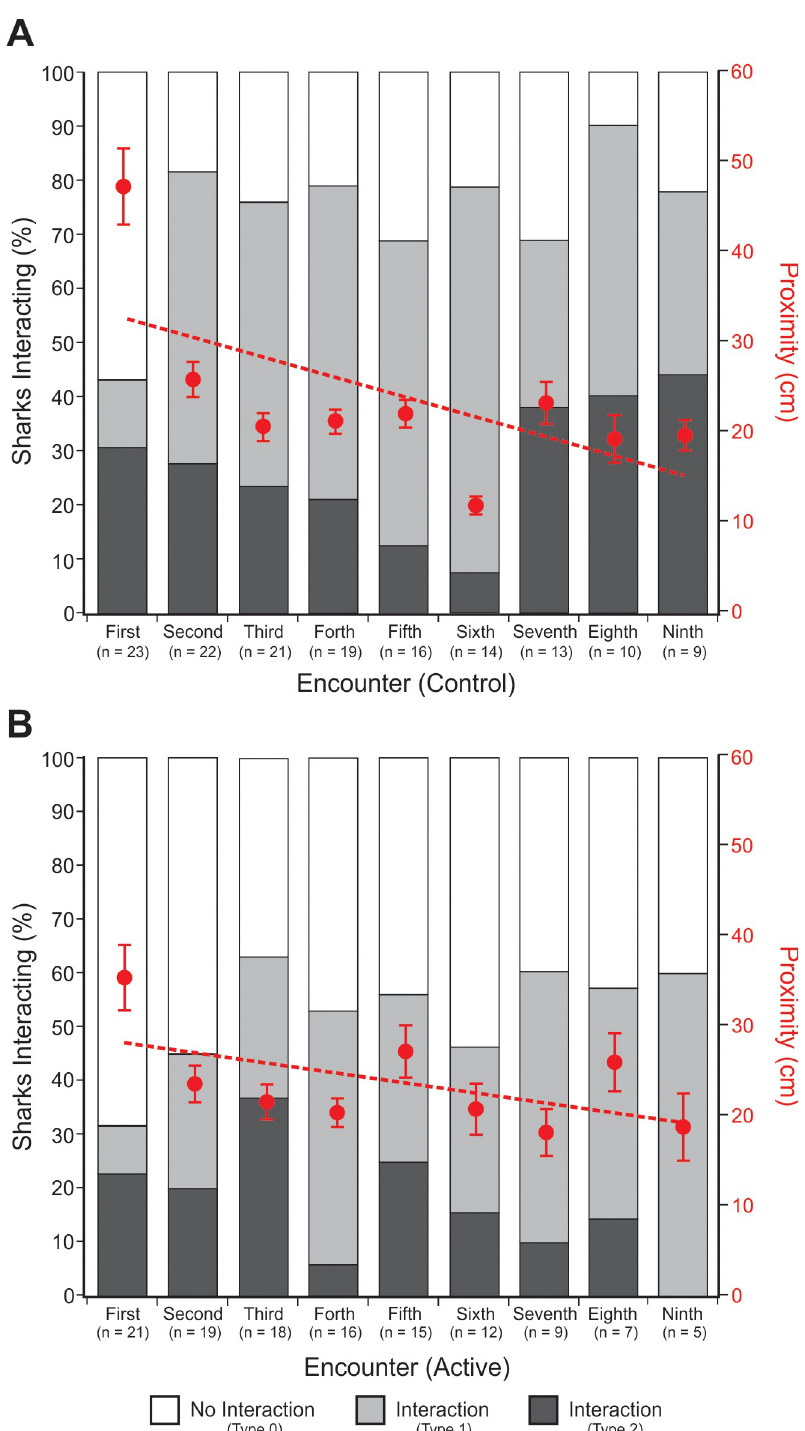
Fig 5. Proportion of sharks that interacted per encounter during control (A) and active (B) ESDS trials. Overlaid is the average proximity of sharks to the ESDS during each encounter. Proximity trend line (Control): y = -22.083x + 346.6; Proximity trend line (Active): y = -10.753x +